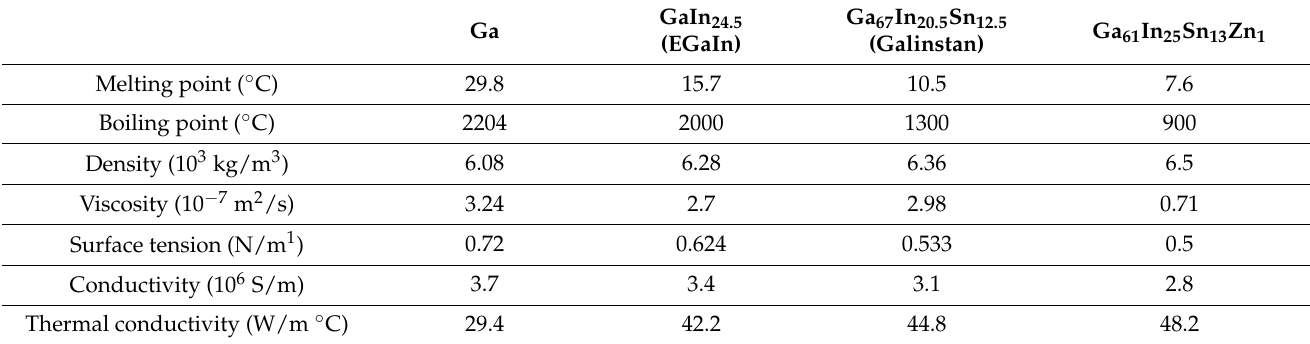
Table 1. The physical properties of common liquid metals [39,47,50].